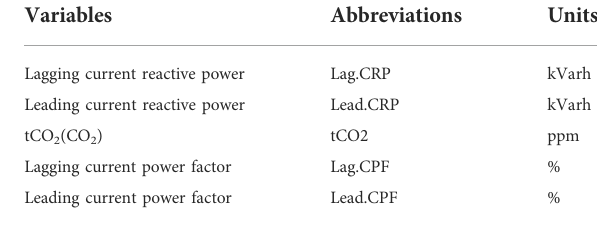
TABLE 2 Comparison of the Prediction Performance on OCI over four steps ahead.